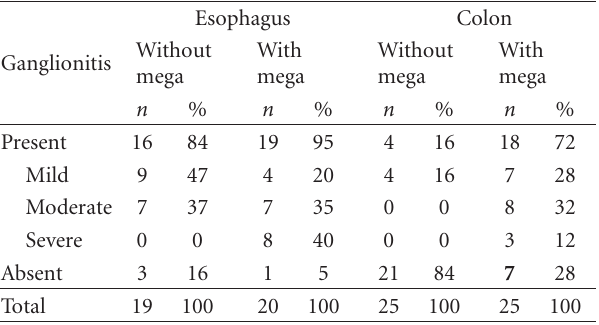
Table 2: Distribution of cases according to the study groups and intensity of esophagus and colon